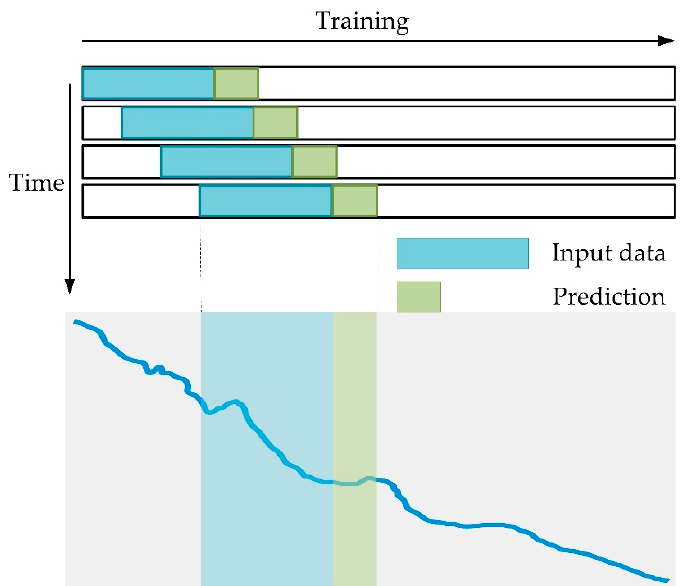
Figure 8. Schematic diagram of track training over time, with blue representing the input training data and green representing the output corresponding to each batch of input. With the change of the training time, an epoch is finished when all the training sets are used.